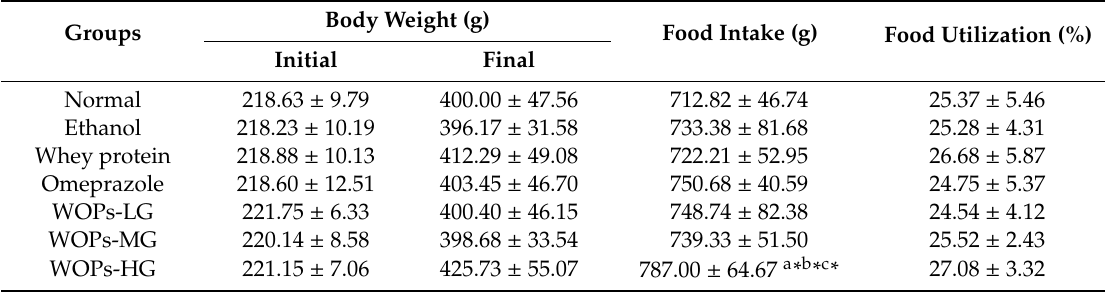
Table 2. E ff ects of walnut oligopeptides (WOPs) on body weight and food